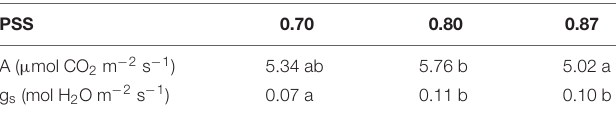
TABLE 4 | Net leaf photosynthesis (A) and stomatal conductance (g s ) of tomato leaves in relation to three levels of PSS, measured under growth light spectrum (total light intensity ≈ 160 µ mol m − 2 s − 1